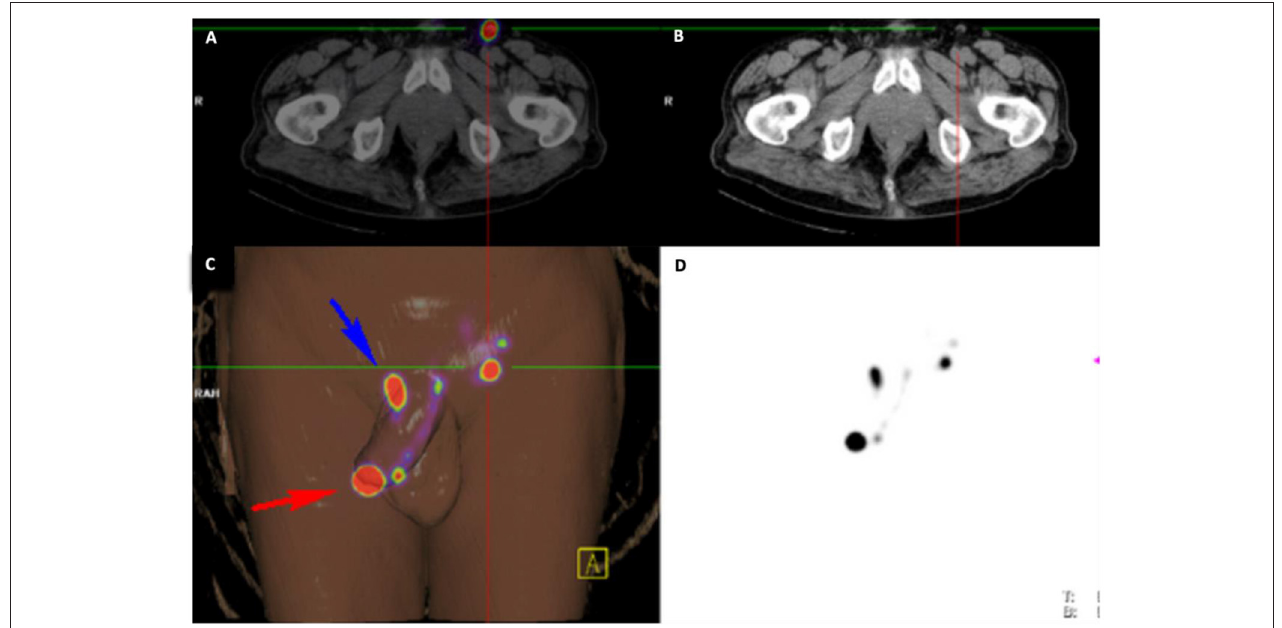
FIGURE 1 | Imaging Overlay for Patient B. The primary penile lesion and left inguinal node is identified with radiotracer hold up at the base of the penis using (A) 18 FDG PET-CT, (B) conventional CT, (C) 3-dimensional digital reconstruction amalgamating information from all imaging modalities, and (D) 99m